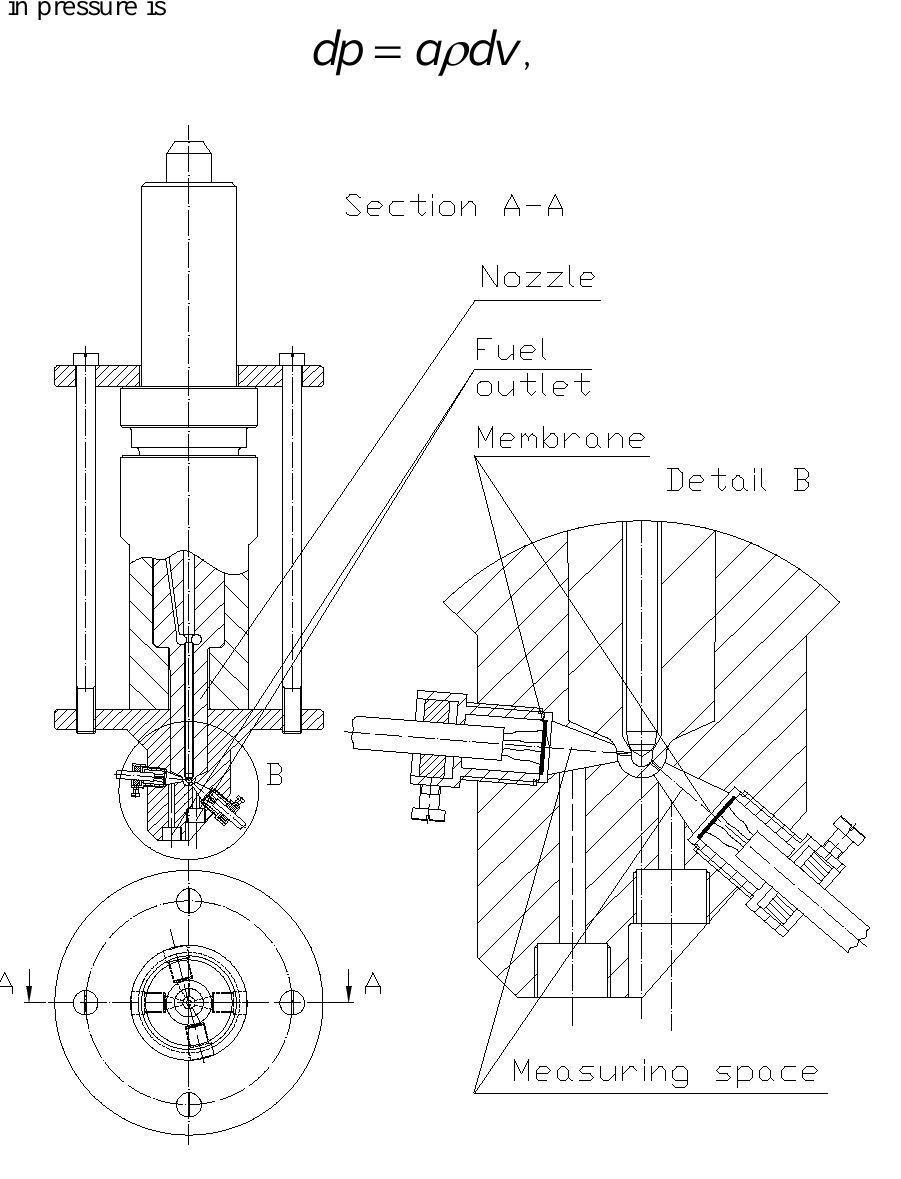
Figure 1. Deformational measuring